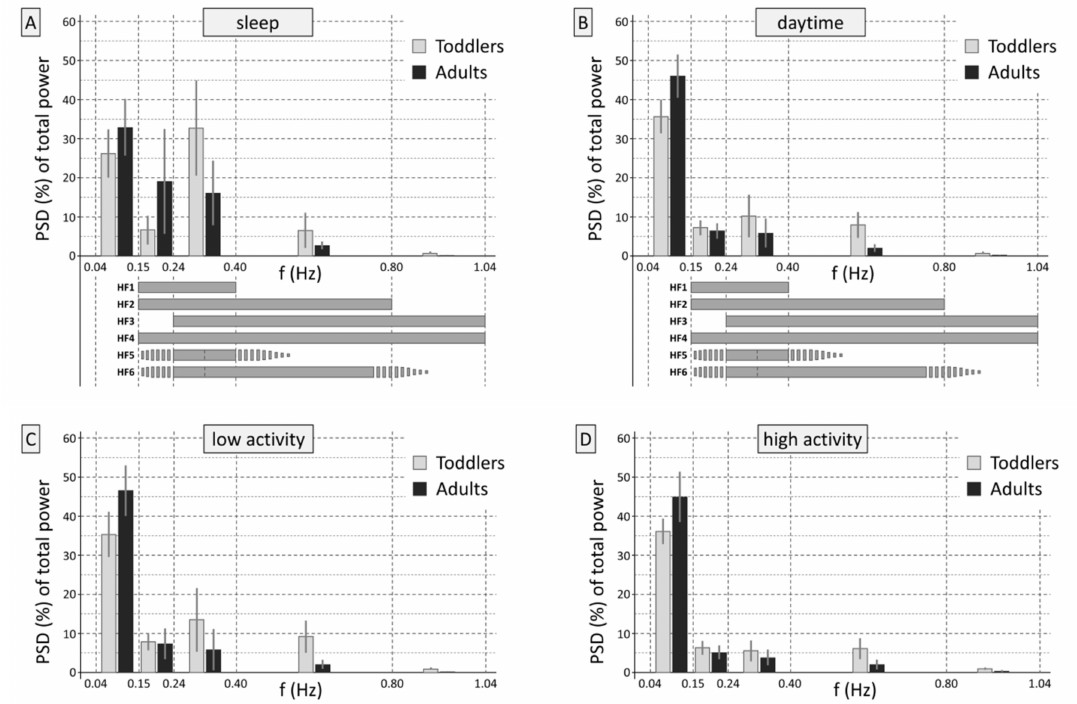
Figure 2. Prevalent frequency ranges (frequency domain). ( A ) shows the proportions of normalized high-frequency (HF) power in the frequency ranges of interest, which were averaged across participants and expressed as percentages of the total heart rate (HR) variability. Adding up the depicted values to HF1 (0.15–0.40 Hz, i.e., 2nd + 3rd column, see schematic bars below parts ( A , B ), HF2 (0.15–0.80 Hz), HF3 (0.24–1.04 Hz), and HF4 (0.15–1.04 Hz) provides an impression of the power spectral density estimates for these frequency bands, independently from the RRI level. Furthermore, the proportion of long-term variability can be seen in the low-frequency range (0.04–0.15 Hz). During sleep, the di ff erence in the dominant HF frequency band between toddlers and adults—in toddlers 0.24–0.40 Hz—can be seen clearly. ( B ) shows the normalized HF power during the day, and ( C , D ) displays the separate analyses for periods with low and high levels of activity during the